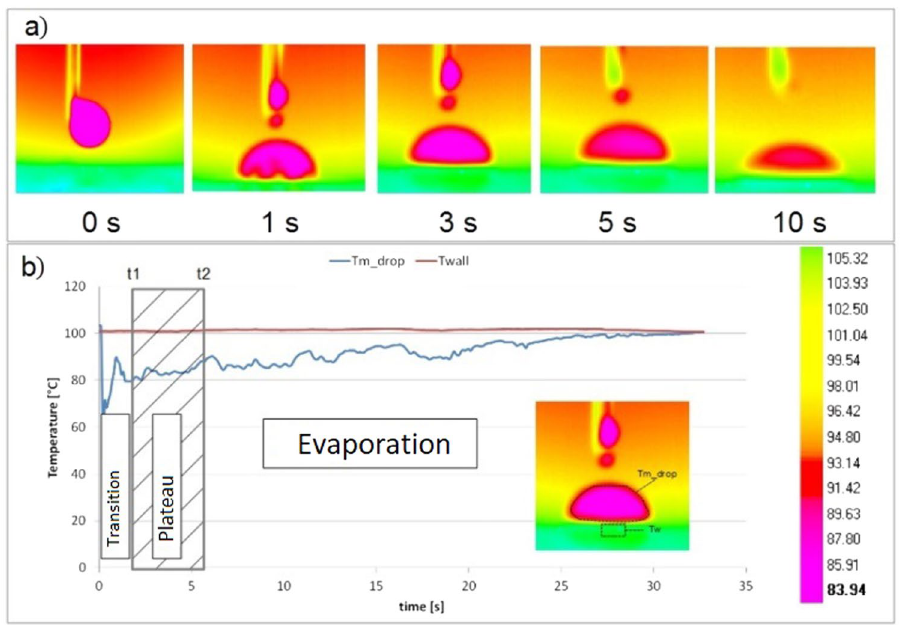
Figure 2. IR-camera images of a sessile water drop deposed on a hot aluminium surface. T w = 100 °C. The contour plots values are set for the droplet object. The IR-camera is calibrated with emissivity of water, therefore only the temperature values of the liquid droplet are real in the